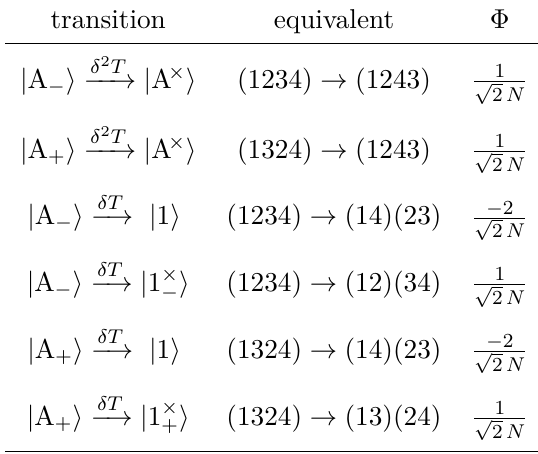
Table 2 . The last group of transition sequences from table 1, along with the corresponding factor Φ appearing in